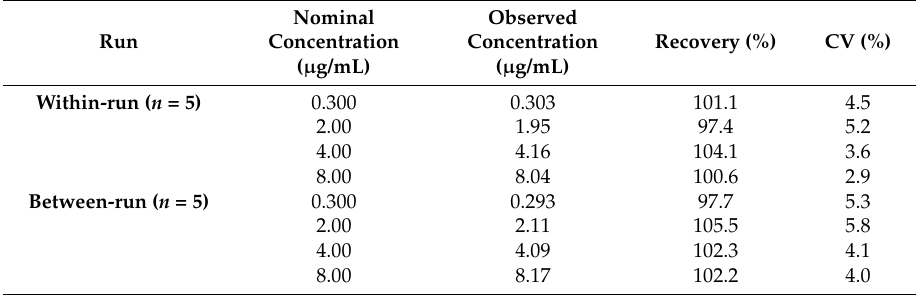
Table 3. Method precision and